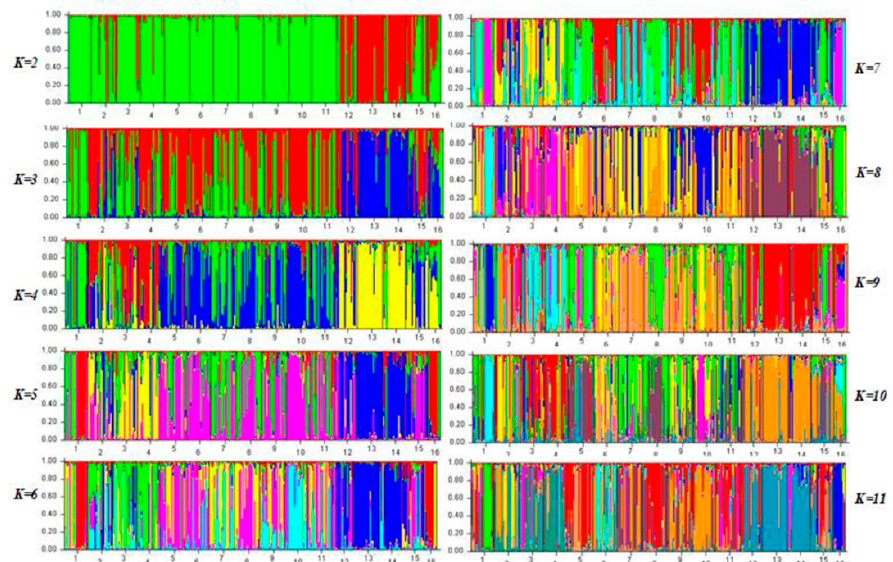
Figure 5. Population structure of 296 C. dactylon plants sampled from 16 populations based on expressed sequence tags-derived simple sequence repeat (EST-SSR) markers ( K = 2 to K = 11). Each color shows one Bayesian ancestry group ( K ). The length of the colored segment represents the estimated membership proportions in di ff erent Bayesian ancestry groups ( K ). Population numbers from left to right are from south to north of China along the latitudinal gradients. Bayesian clustering and population modeling was performed using a STRUCTURE V.2.2. Table 6. The model values of the K versus DeltaK distribution. K L(K)